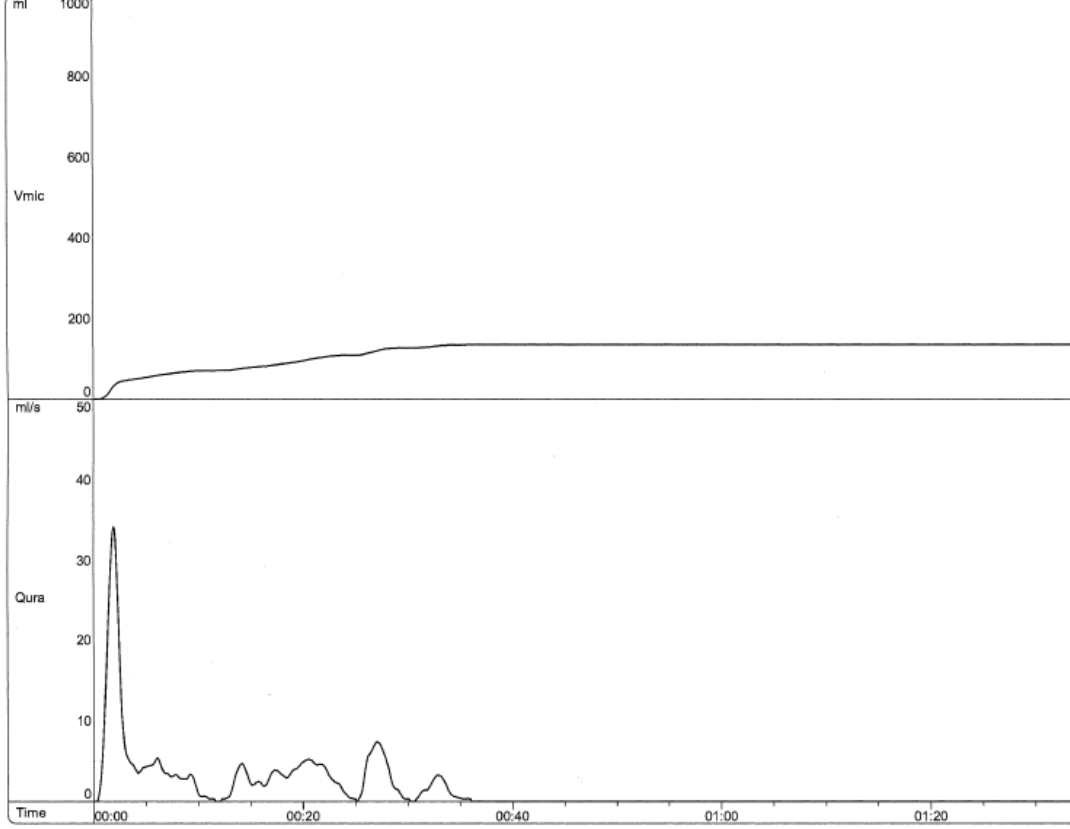
Figure 2. Uroflow (6/2018) Post 3 years of “traditional” bladder retraining without addition of movement therapies (Staccato and prolonged).